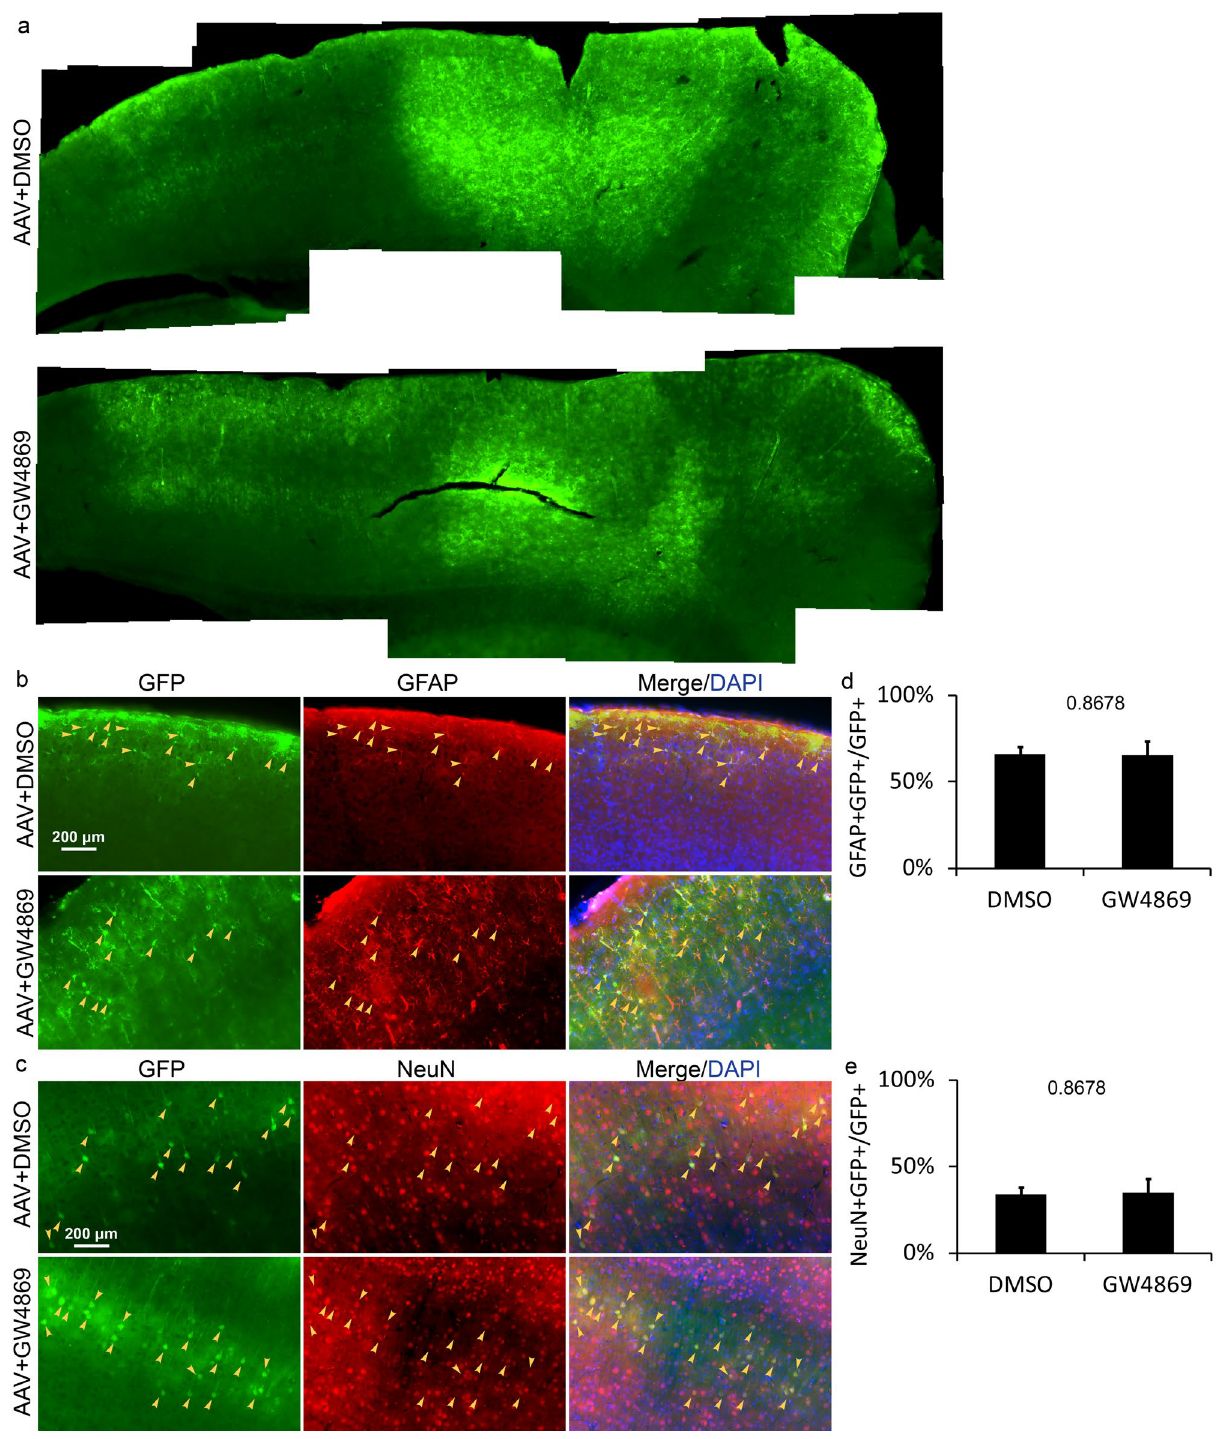
Figure 4. EFGP distribution in the cortex 10 days after injecting AAV and DMSO/GW4869. ( a ) The microscopic photo with low magnification shows EGFP+ cells in cerebral cortex. ( b ) and ( c ) Detection of EGFP distribution in astrocytes of layer I–III and neurons of layer V at 10 DPI. Yellow arrows, double positive cells. ( d ) and ( e ) The percentage of astrocytes and neurons in EGFP+ population at 10 DPI. Statistical analysis of significance was evaluated using unpaired two-tailed t test, N = 3 independent